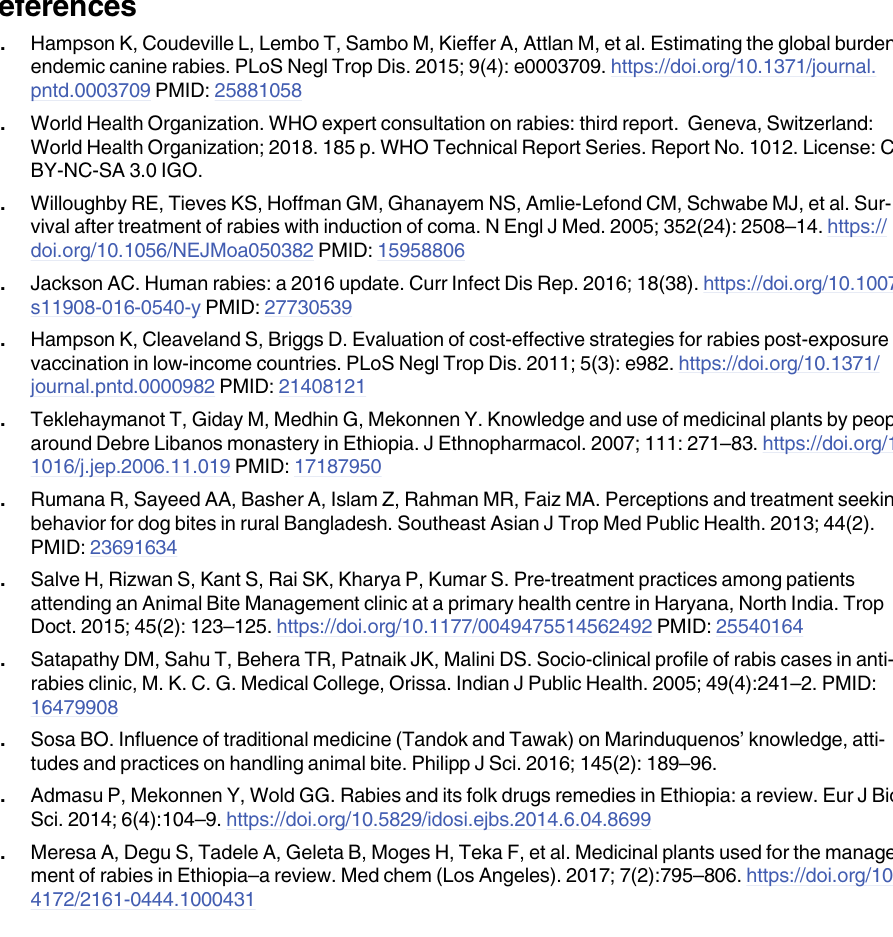
S1 Appendix. Table of plants used for human rabies or dog bite treatments listed in 15 of the 18 surveys included in this literature